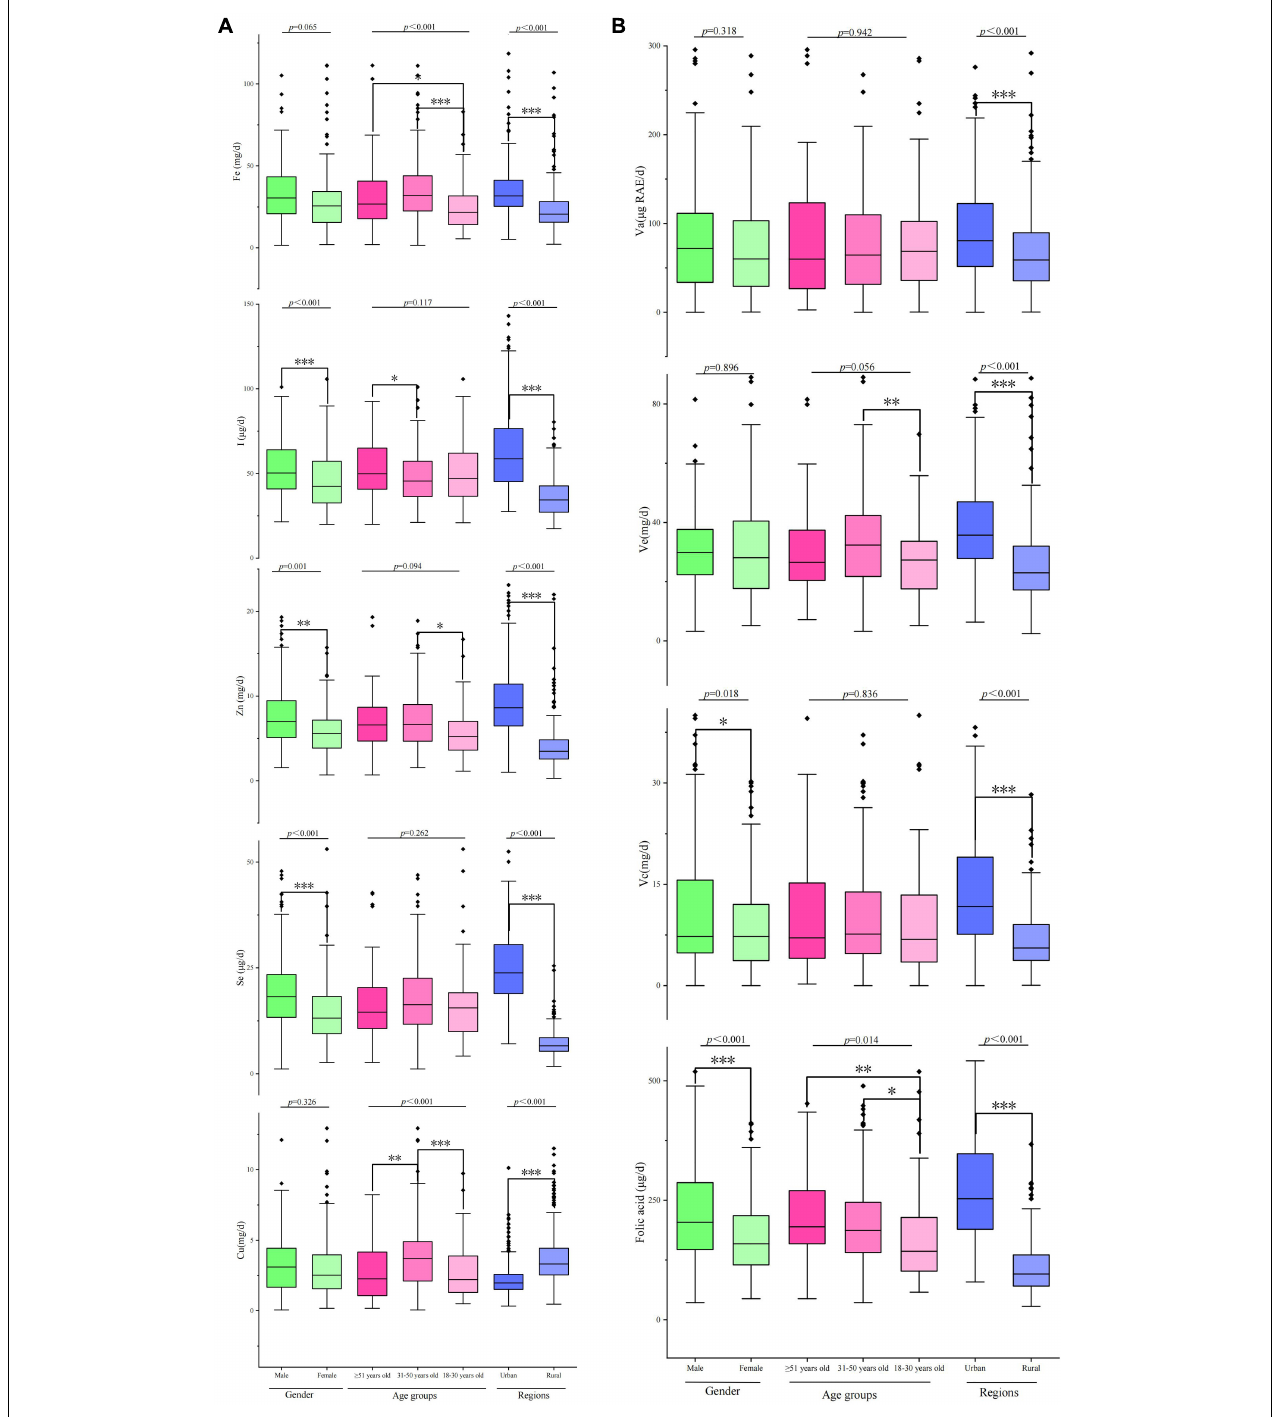
FIGURE 3 | Micronutrient (Fe, I, Zn, Se, and Cu) and vitamin (Va, Ve, Vc, and folic acid) intakes of Tibetan adults living in agricultural counties of T.A.R. ∗ p < 0.05; ∗∗ p < 0.01; ∗∗∗ p < 0.001.